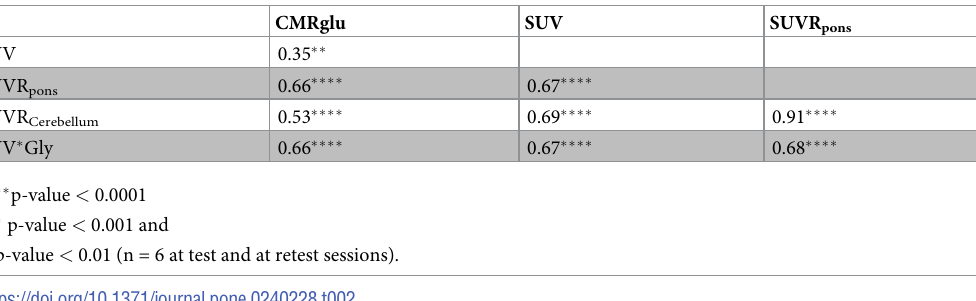
Table 2. Spearman’s rank correlations between outcome parameters from the [ 18 F]FDG test-retest